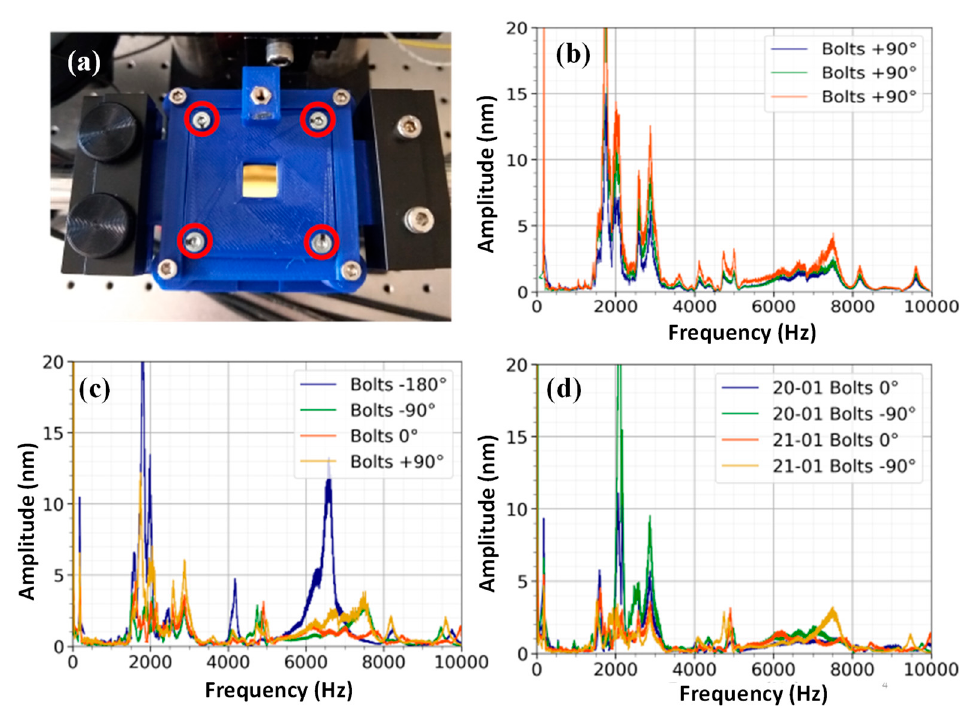
Figure 3. ( a ) The sandwiched membrane in between two plates with an o-ring and four bolts. The pressure exerted by the o-ring depends on how much the bolts, circled in red, are tightened. ( b ) Three consecutive measurements of the membrane at a specific bolt rotation. Measurements were taken at 1 min intervals, and they show a consistent frequency response. ( c ) The frequency response of the membrane is mapped at the center of the membrane for varying bolt rotations. The baseline rotation of 0° is set to four full rotations. ( d ) Spectra of the membrane are compared for a repeat of the experiment on the next day. The piezo element was used to generate a frequency chirp pattern with a duration of 150 s at an amplitude of 10 Vpp. The distance from the piezo to the membrane was set at approximately 5 mm.